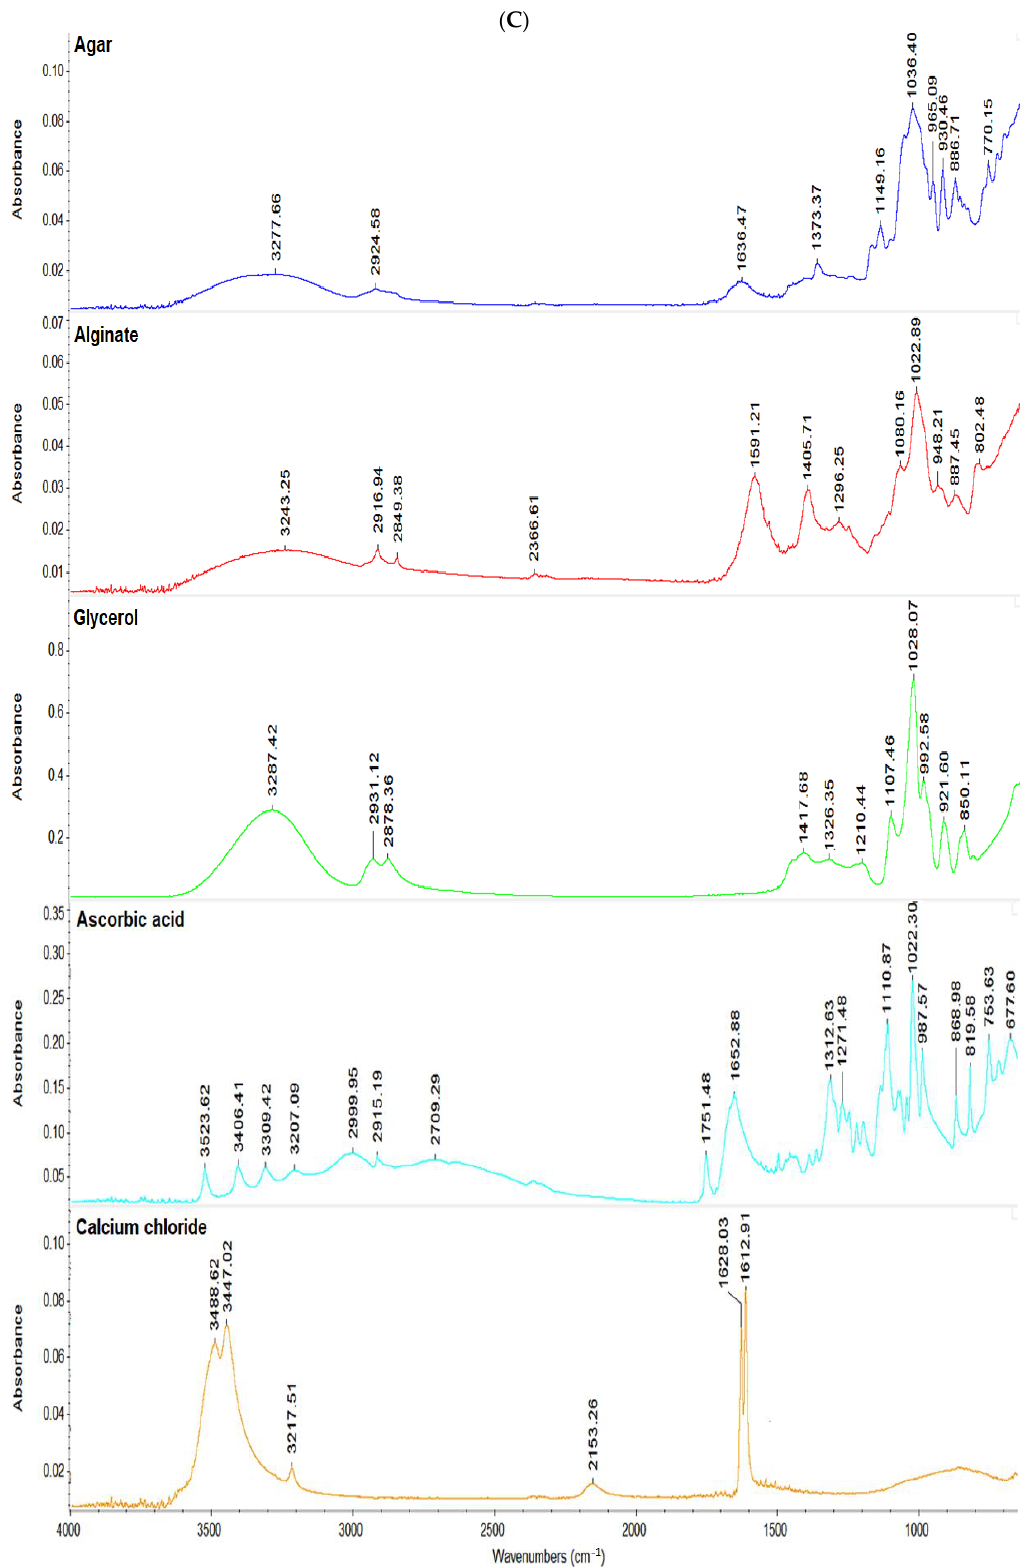
Figure 4. FTIR-ATR spectrograms: ( A )—stacked absorption spectra of the membranes with AA addition and control sample; ( B )—stacked absorption spectra of the membranes with CaCl 2 addition and spectra of the control sample; ( C )—stacked absorption spectra of the individual